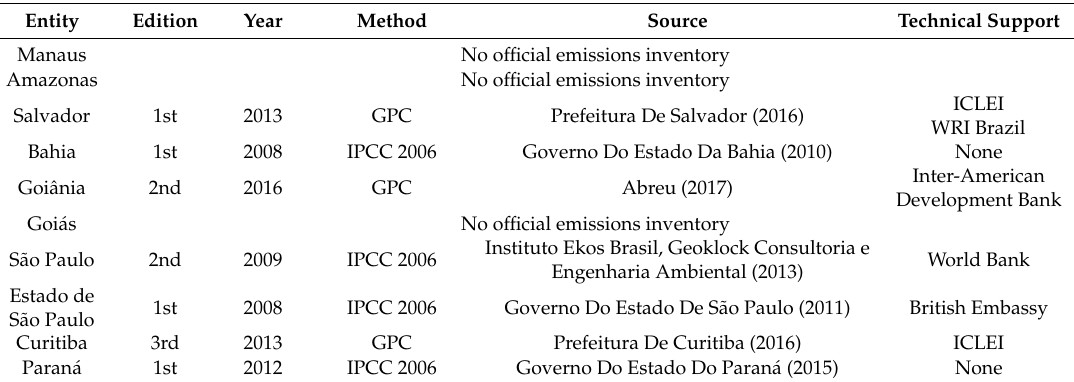
Table 5. State- and city-level GHG inventories *